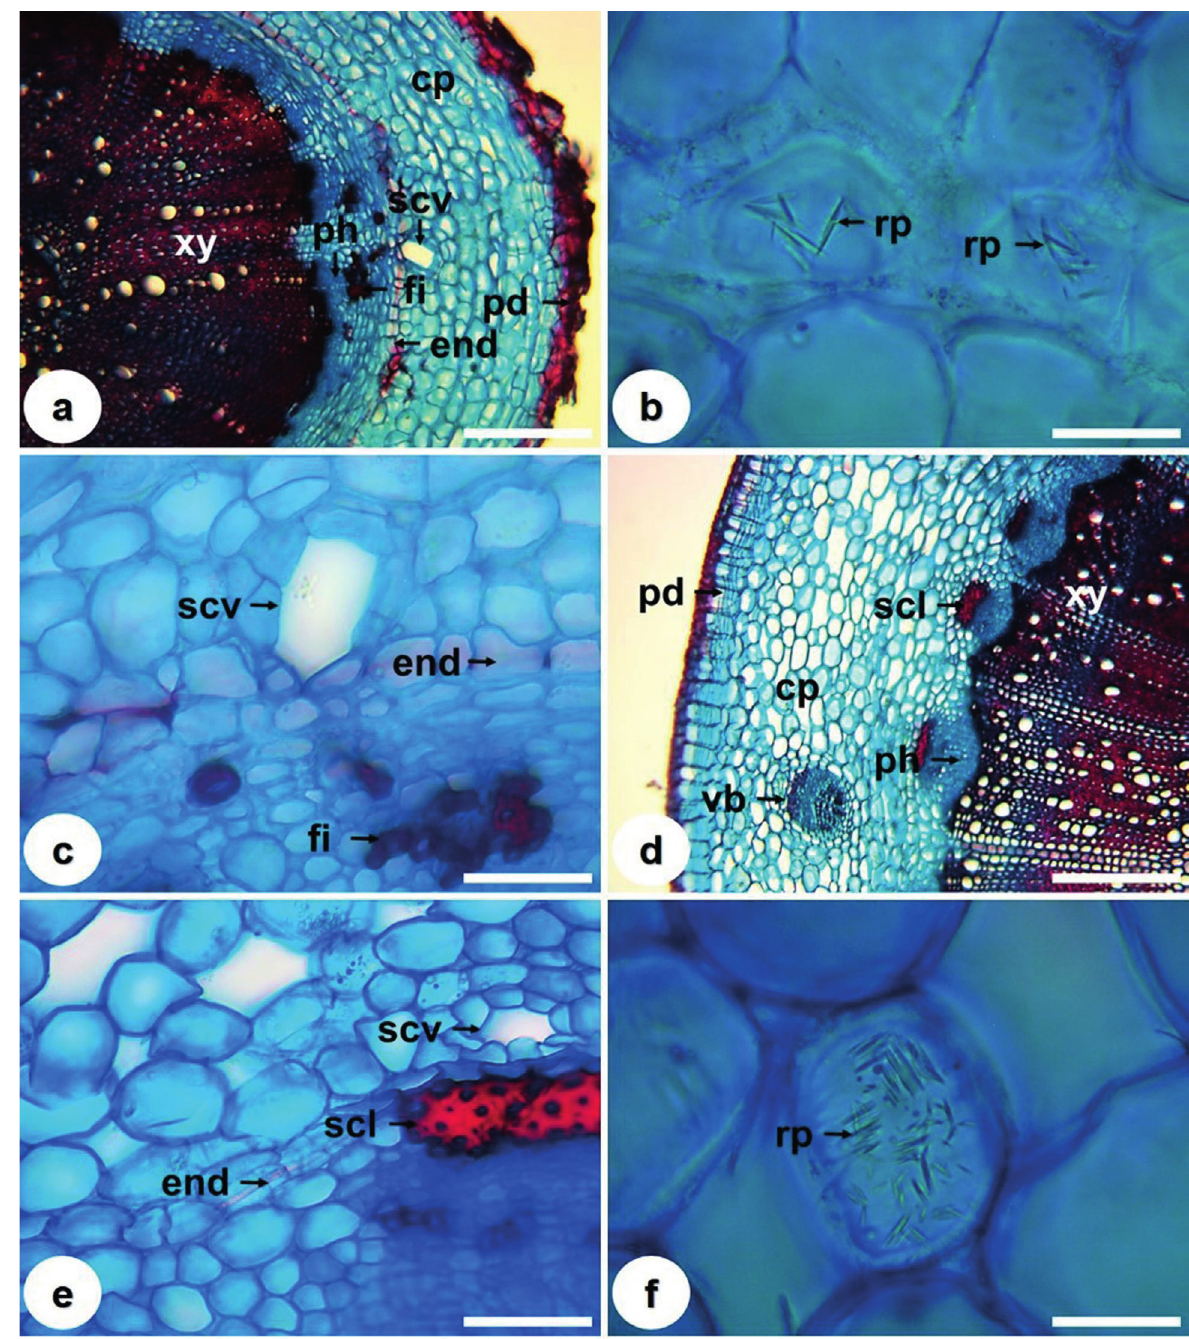
Figure 1 - Solidago chilensis Meyen (Asteraceae) - cross-sections of root and stem. (a) General aspect of the root showing peridermis (pd), cortical parenchyma (cp), secretory cavity (scv), endodermis (end), fibers (fi), phloem (ph) and xylem (xy). (b) Idioblasts with raphides (rp) in cortical region of the root. (c) Detail of the secretory cavity (scv) in cortical region of the root associated with endodermis (end) and fibers (fi). (d) General view of the stem showing peridermis (pd), cortical parenchyma (cp) with isolated vascular bundle (vb), sclerenchyma (scl), phloem (ph) and xylem (xy). (e) Detail of secretory cavity (scv) in cortical region of the stem associated with endodermis (end) and sclerenchyma (scl). (f) Idioblast with raphides (rp) in cortical region of the stem. Bars: a , d = 200 µm; b and f = 20 µm; c and e = 50